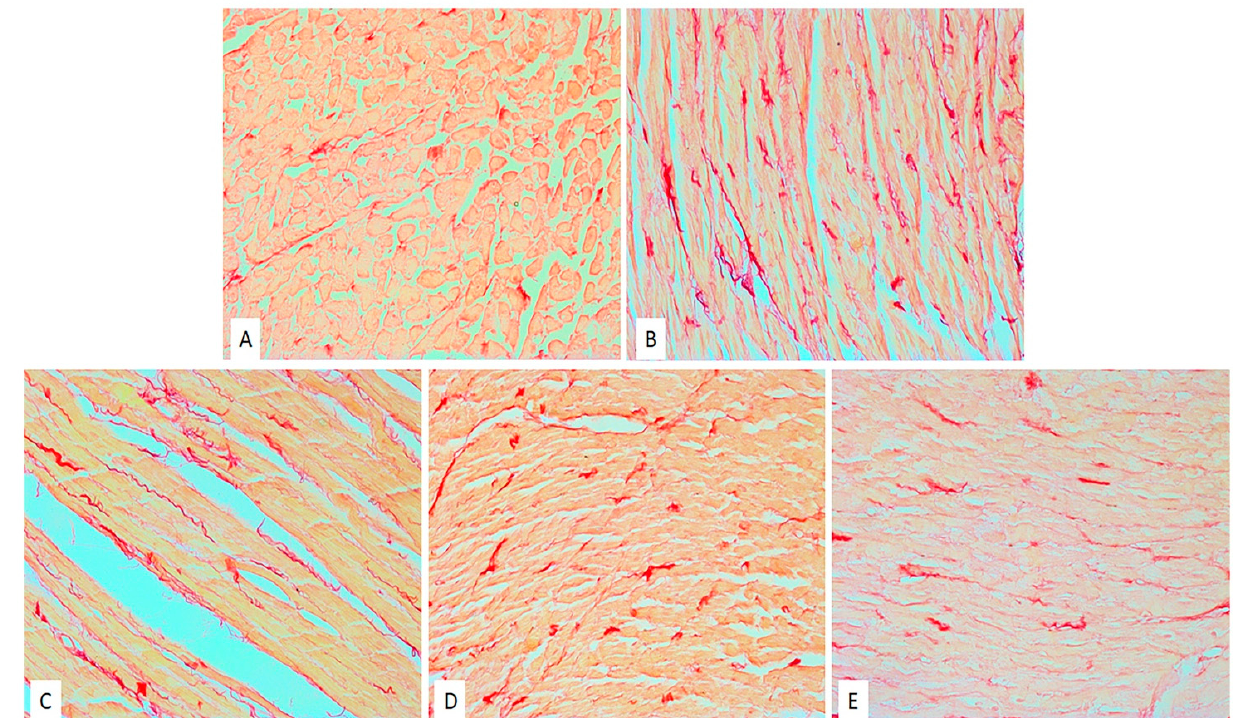
Figure 5. Effects of short-term heart preconditioning with ME on heart tissue collagen content. Representative heart tissue sections of Picrosirius red staining. Magnification 20× scale bar = 50 µm. ( A ) SHAM; ( B ) CTRL; ( C ) ME50; ( D ) ME100; ( E ) ME200.